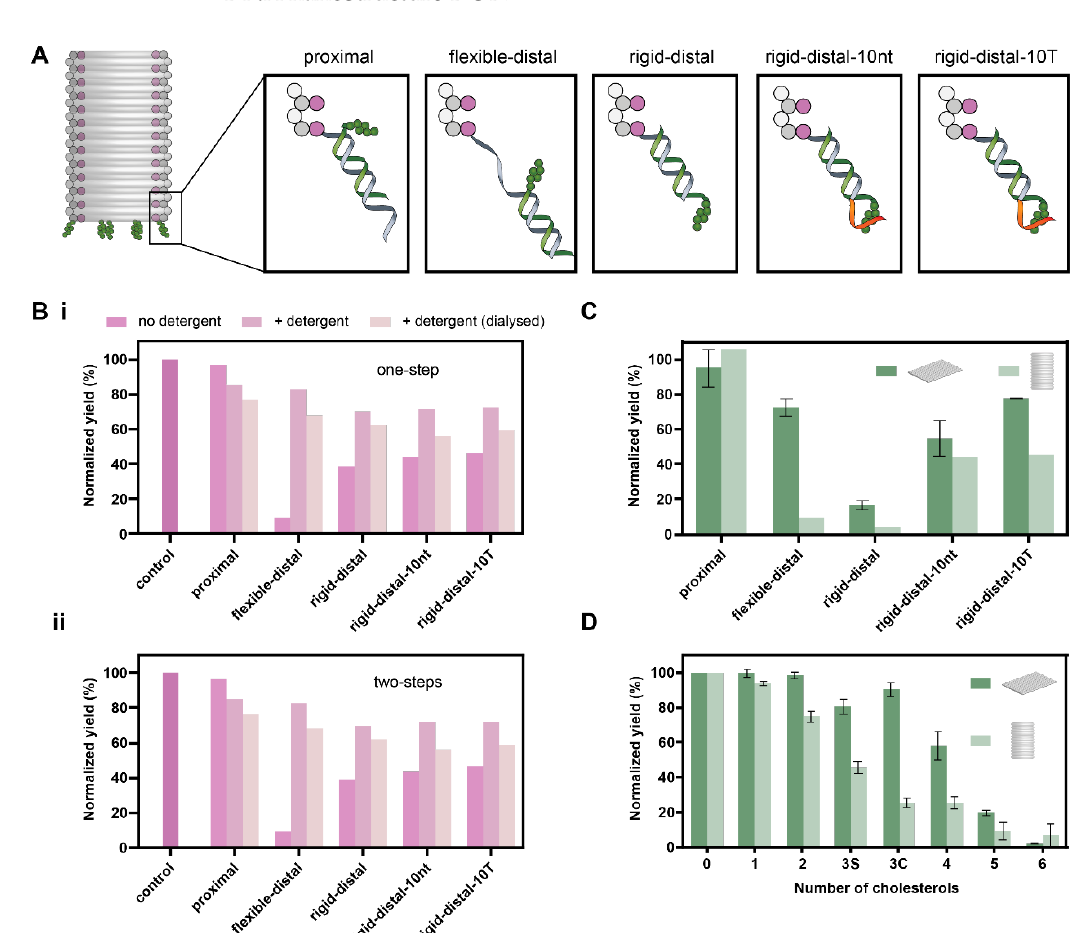
Figure 4. Aggregation study of the DOB. ( A ). Schematic showing the different spacer designs for cholesterol attachment. In all cases, the staple (grey) from the DOB is extended from its inner helix. Cholesterol strand: green. Overhang: orange; ( B ). Normalized DOB yields based on gel analysis for ( i ) one-pot and ( ii ) two-step cholesterol attachment. A lower yield indicates more aggregation; ( C ). Comparison of normalized yield of DOT and DOB. Gel bands for each design were normalized to the control band in the gel. One-pot folding results (no detergent) were used for the DOB; ( D ). Normalized yields of the DOT and DOB with different number of cholesterols.